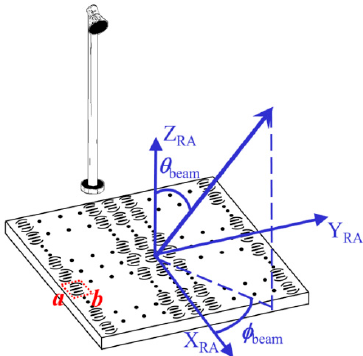
Figure 6. Reflectarray antenna picture. Coordinate system with origin at the reflectarray center and beam direction.